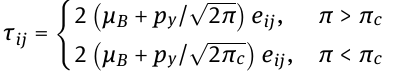
The rheological equation of state for the Cauchy stress tensor of Casson fluid can be written as [20, 21]